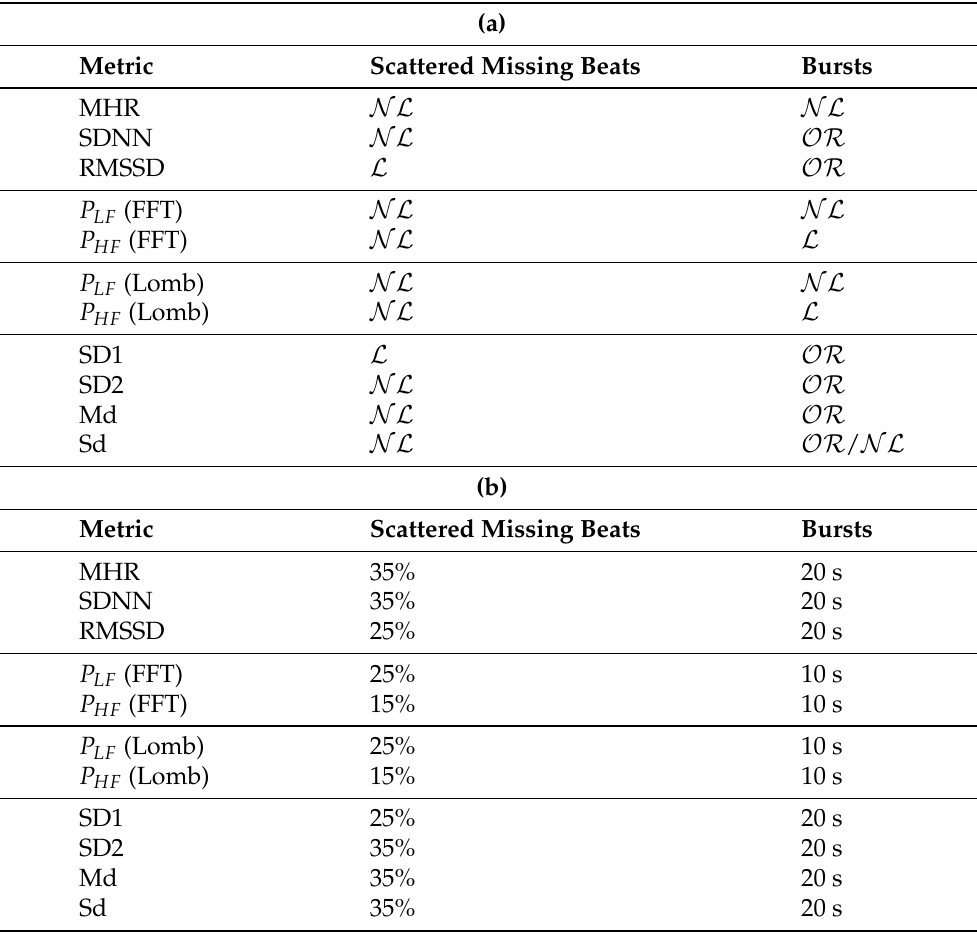
Table 13. Summary of findings. (a) Best correction method. (b) Maximum acceptable missing beats for a relative error less than 20% in the third